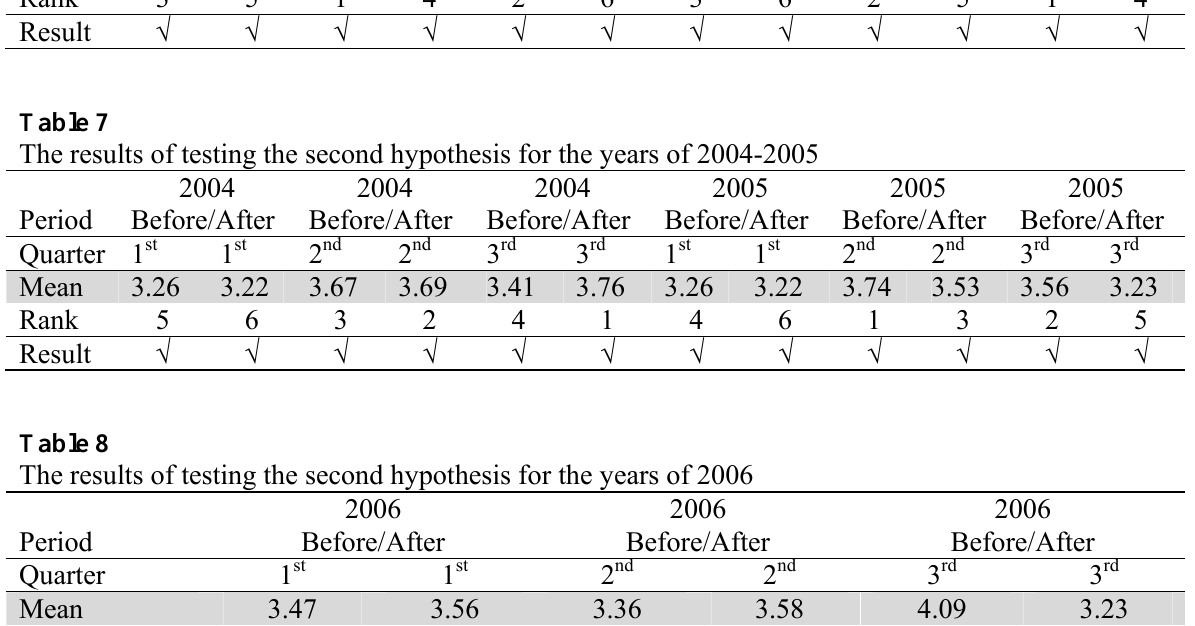
The results of testing the second hypothesis for the years of 2002-2003 2002 Period Before/After Before/After Before/After Before/After Before/After Before/After Quarter Rank Result